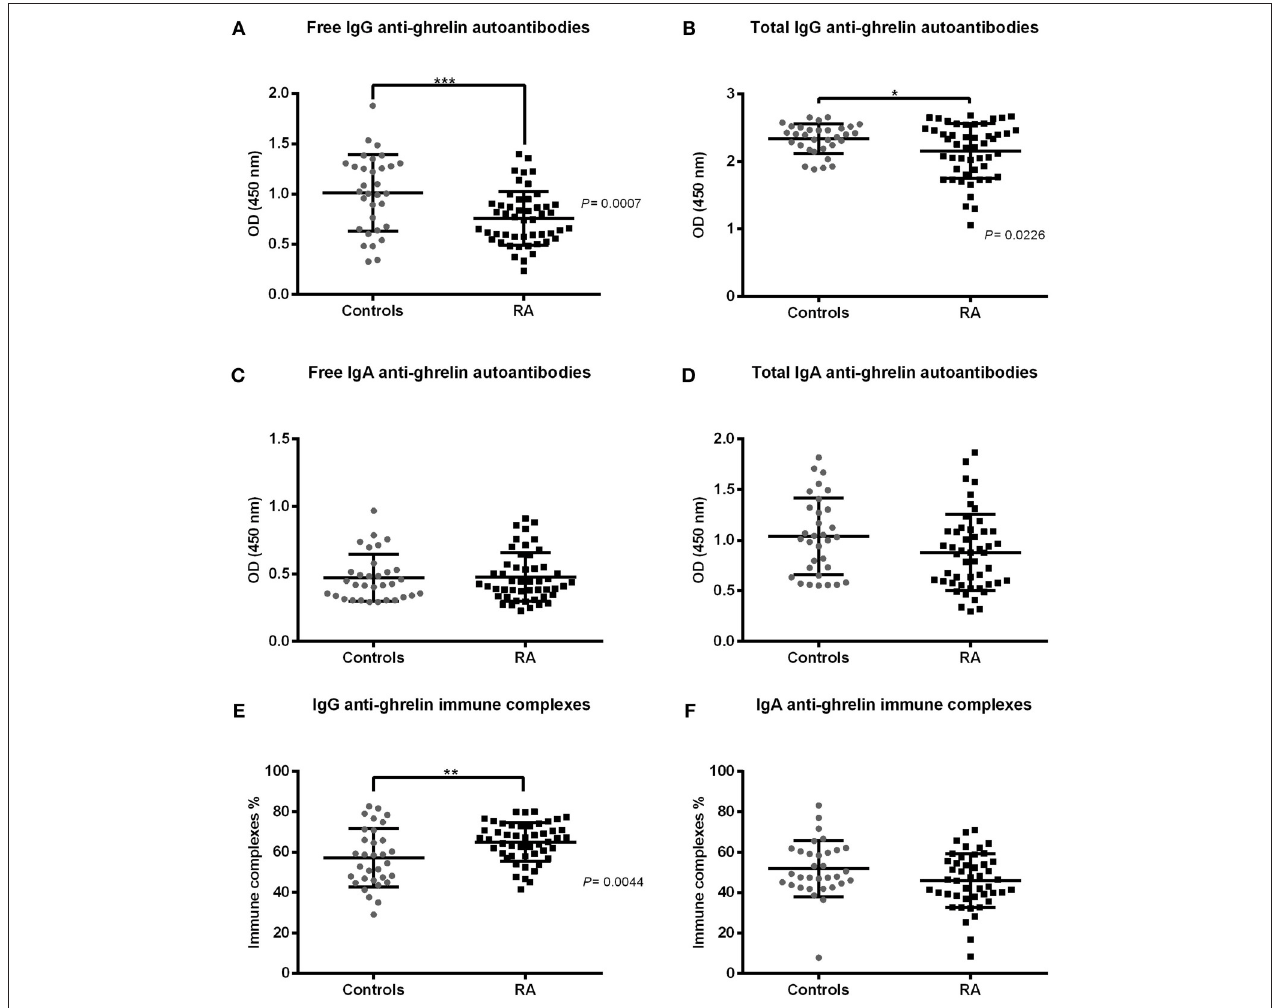
FIGURE 1 | IgG and IgA anti-ghrelin autoantibodies levels in rheumatoid arthritis (RA) patients and controls. IgG and IgA anti-ghrelin autoantibodies serum levels are expressed in optical density (OD). (A,C) Free IgG and IgA autoantibodies. (B,D) Total IgG and IgA anti-ghrelin autoantibodies. (E,F) IgG and IgA immune complexes percentage. Controls n = 32, RA n = 49. Horizontal lines indicate mean and standard deviation. Difference between groups was assessed by Student’s t -test or Mann-Whitney U -test, as appropriate. P -values ≤ 0.05 were considered statistically significant (* p < 0.05, ** p < 0.01, *** p < 0.001).